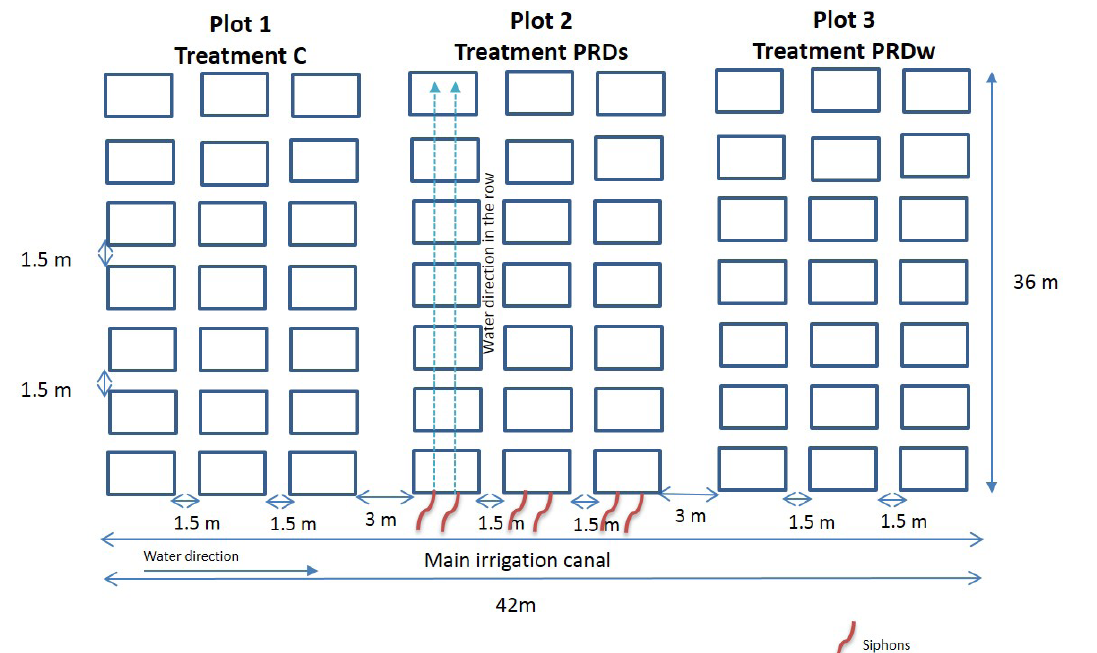
Figure 1. Demonstration trial conducted in Ethiopia in 2014. C = Customary irrigation, PRDs = partial root-zone drying with siphons, PRDw = partial root-zone drying without siphons Table 1. Assessment of infiltration rates of the experimental field Starting time